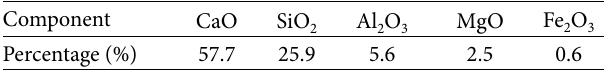
Figure 4: N,N-Ddimethylp-toluidine (DMT). Table 2: Main components of stone